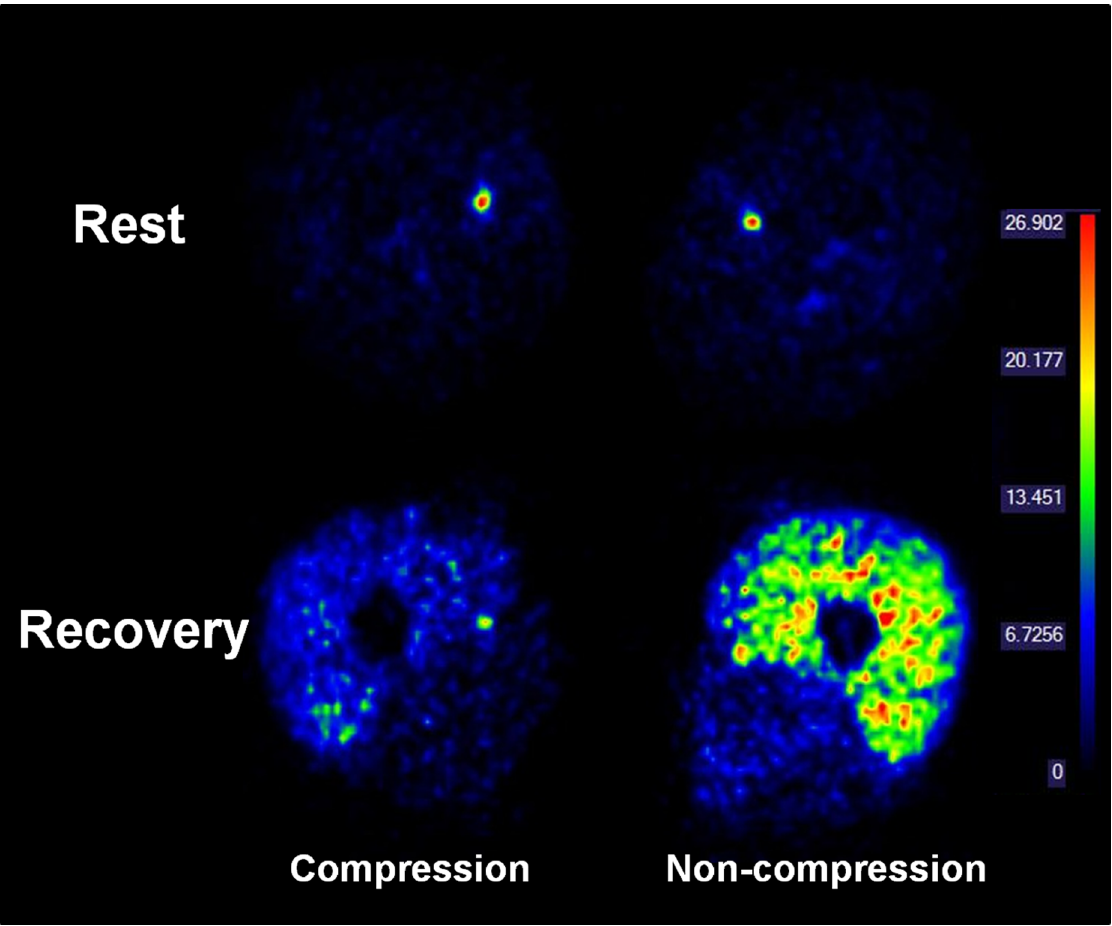
Figure 2. A representative example of muscle blood flow PET image before (rest) and after (recovery) the high intensity exercise. This figure illustrates that blood flow is lower in compressed compared to non-compressed leg. The color bar on the right side of the figures represents the quantitative scale for blood flow values. doi:10.1371/journal.pone.0060923.g002 PLOS ONE |